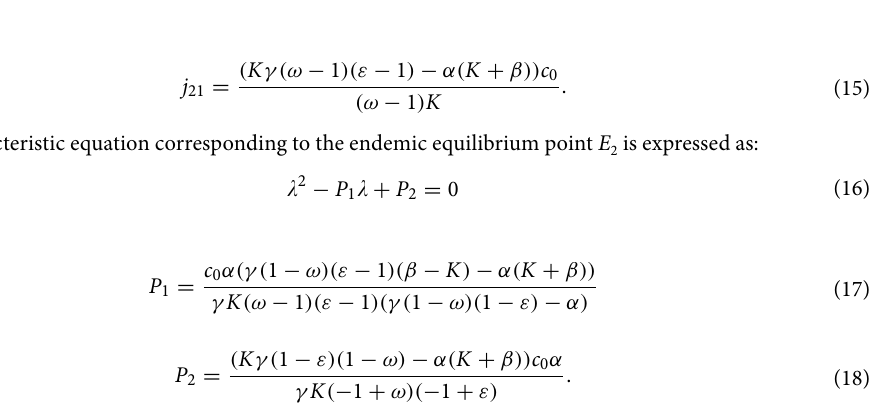
Figure 7. Illustration of the stability diagram of (ω , ε) for within patch model using parameters values in Table 2. ( a ) Stability diagram of the pathogen free equilibrium point and, ( b ) stability diagram of the endemic equilibrium